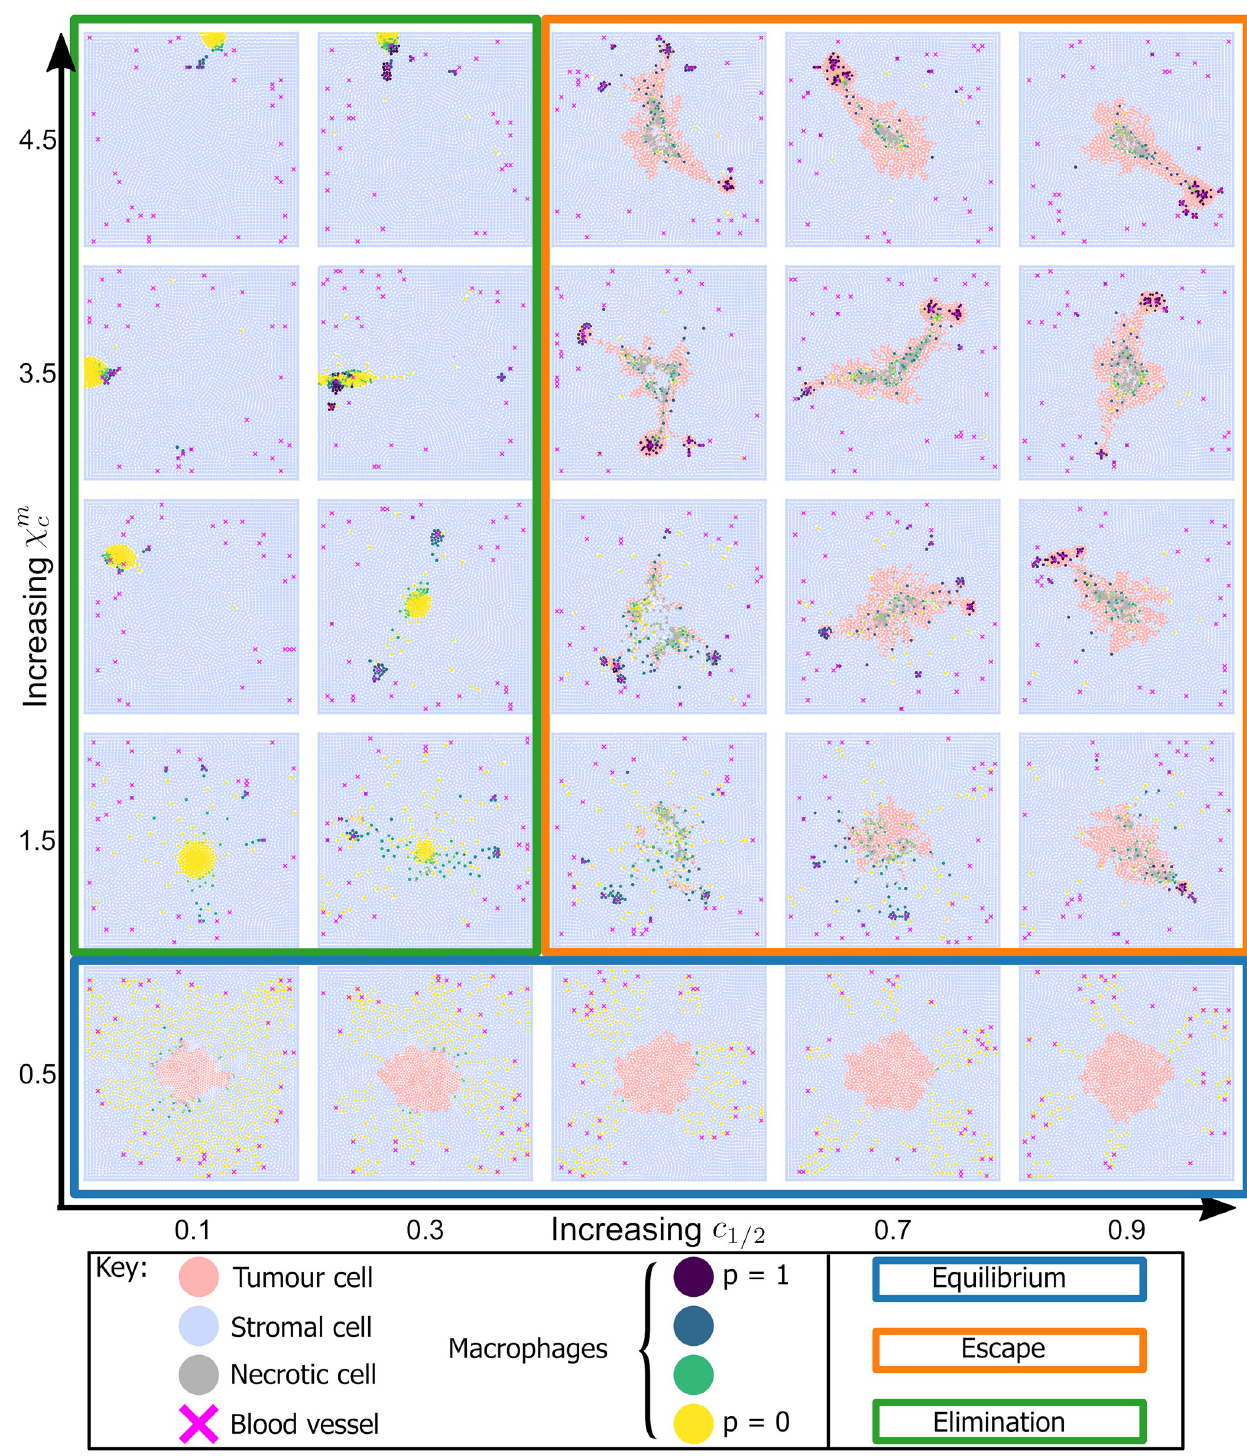
Fig 4. Varying macrophage sensitivity to environmental cues generates diverse patterns of tumour growth. Representative simulation endpoints for combinations of w m ¼ 0 : 5 ; 1 : 5 ; 2 : 5 ; 3 : 5 ; 4 : 5 and c 1/2 = 0.1, 0.3, 0.5, 0.7, 0.9. We group these into three qualitatively similar behaviours: Equilibrium—blue c box: compact tumour mass, with predominantly